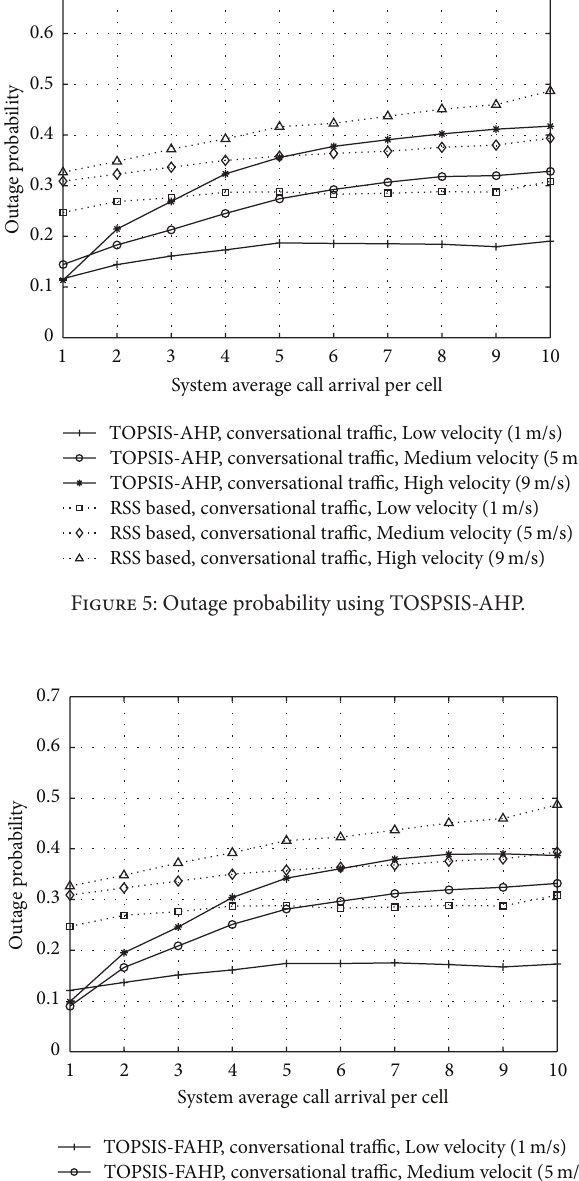
Table 7: Parameter sets for VHONE.